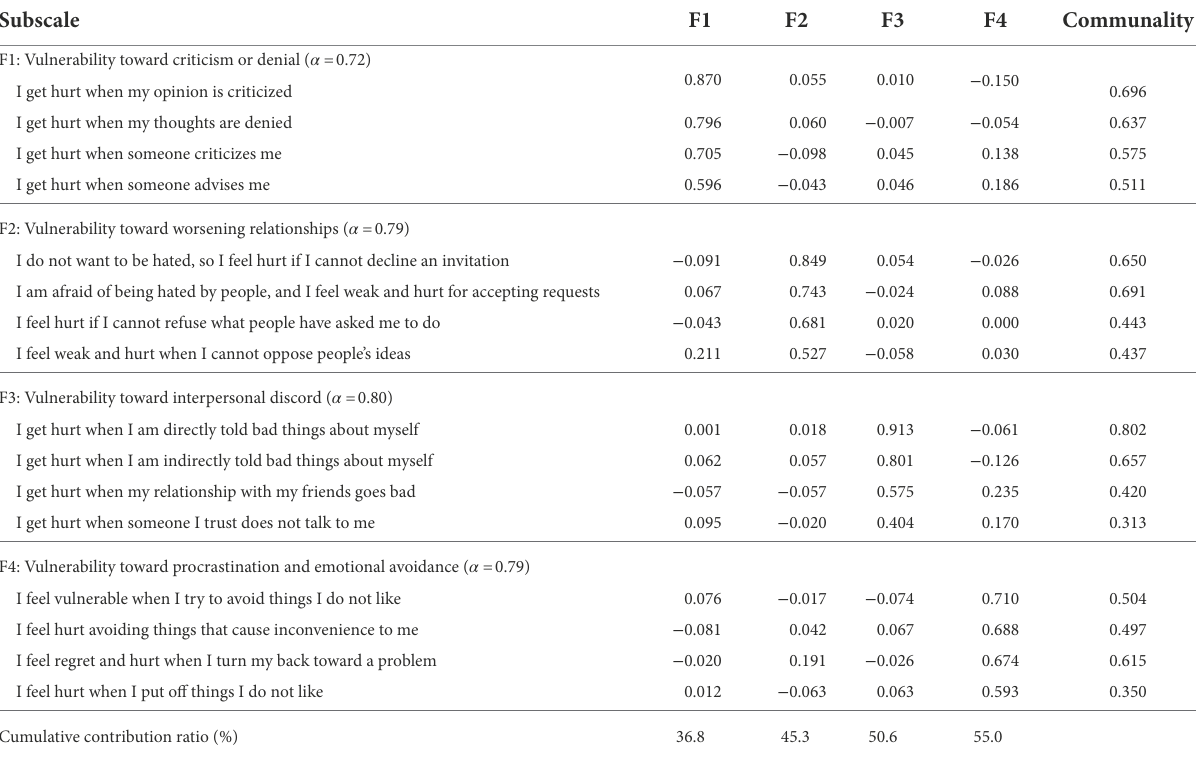
TABLE 1 Results of the exploratory factor analysis.